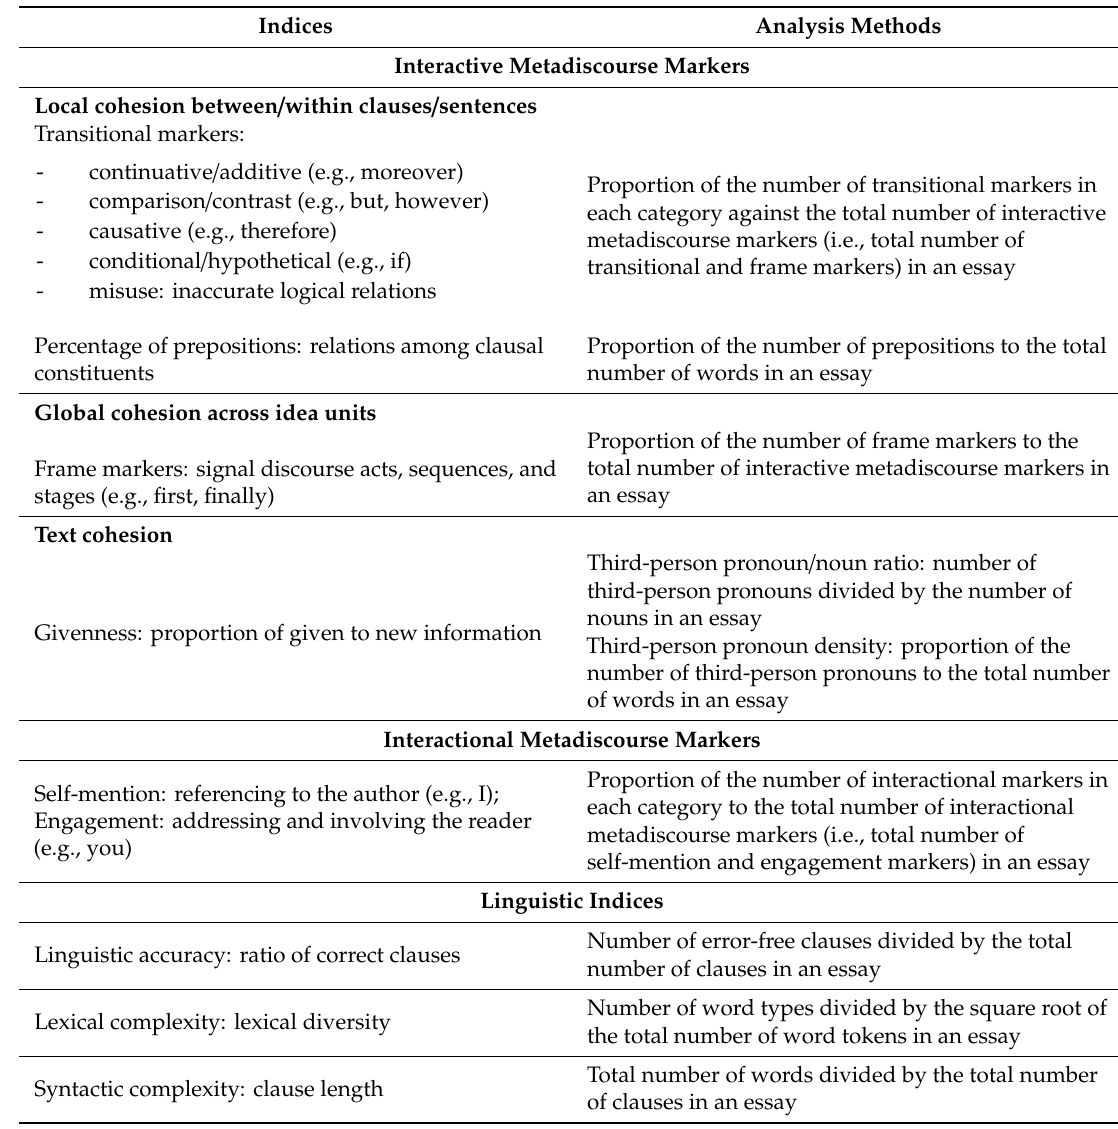
Table 2. Measures used in the current